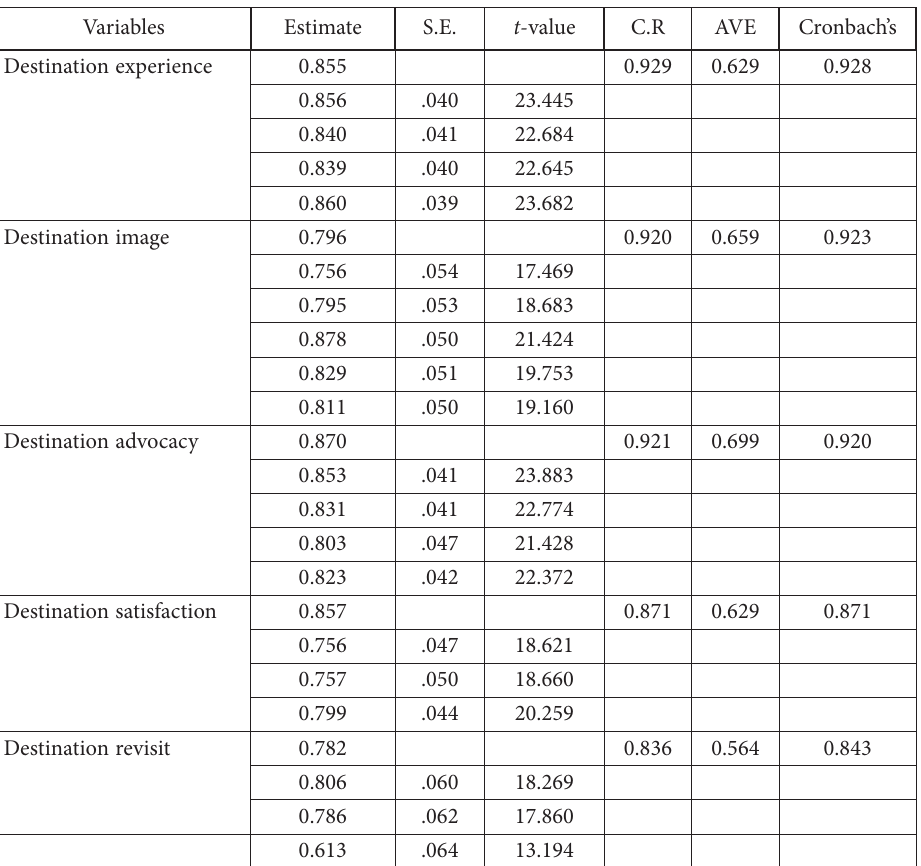
Table 2. Reliability and validity